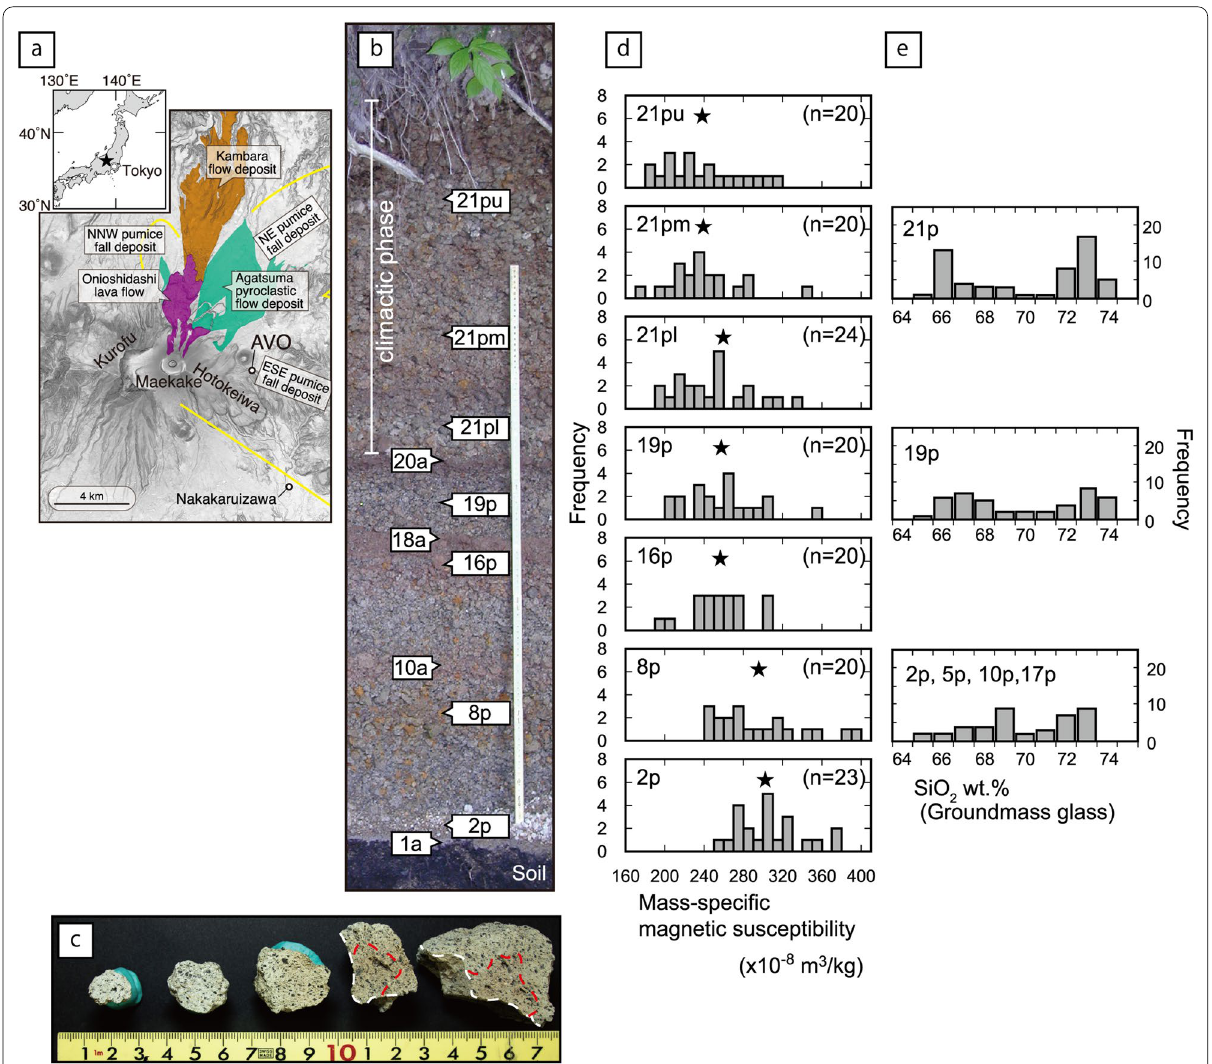
Fig. 1 a Topographic map of Asama volcano consisting of Kurofu volcano, Maekake volcano, and Hotokeiwa volcano. The star in the index map upper left shows the location of the Asama volcano. The distribution of the 1783 eruptive products (Aramaki 1993) is shown. Yellow lines indicate 1 cm isopach of the pumice fall deposits from the 1783 eruption (Yasui and Koyaguchi 2004). AVO Asama volcano observatory. b Photograph showing the occurrence of the ESE pumice fall deposits of the eruption. Letters shown on the photograph indicate the sampled units for this study. The distinctive ash fall deposits shown in Yasui and Koyaguchi (2004) are also shown. The scale bar on the right is 1 m long. c Representative halved sections of pumice samples of various sizes. Pumice samples with the same size as or smaller than the smallest one in this figure were used for this study. White dashed lines indicate broken-out sections of the large samples. Pinkish oxidized parts are surrounded by red dashed line. d Histograms showing the frequency of magnitude of MS of pumice fall deposits. The stars in the diagrams represent the average values. e Histograms showing SiO 2 content of groundmass glass composition of each unit. This is rewritten from Fig. 3 in Yasui (2016) with permission from the Institute of Natural Sciences, College of Humanities and Sciences, Nihon